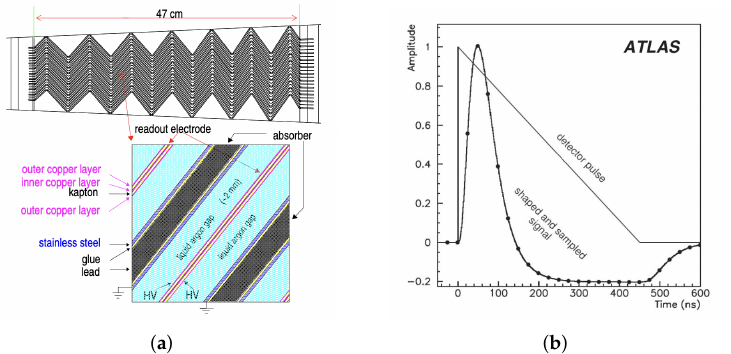
Figure 2. Accordion-shaped LAr gap of the barrel with readout electrodes and high voltage lines ( a ) and triangular pulse produced in the LAr gap compared to the shaped and sampled signal ( b )